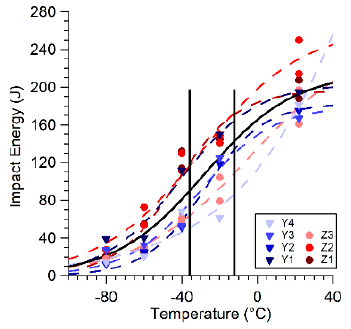
Figure 6. Charpy v-notch impact toughness curves. The figure shows a Ductile to Brittle Transition Temperature (DBTT) increase from − 36 °C to − 17 °C with build height.